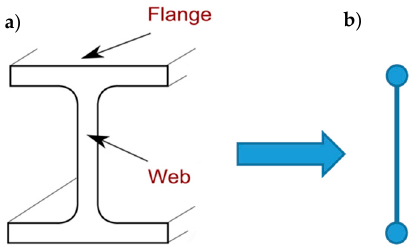
Figure 16. Ideal scheme of behavior of an I-beam: two point masses, linked by a stiffness constraint. Figure 16. ( a ) Cross-section of an I-beam; ( b ) Ideal scheme of behavior of an I-beam in its cross-section: two point masses, linked by a stiffness constraint.